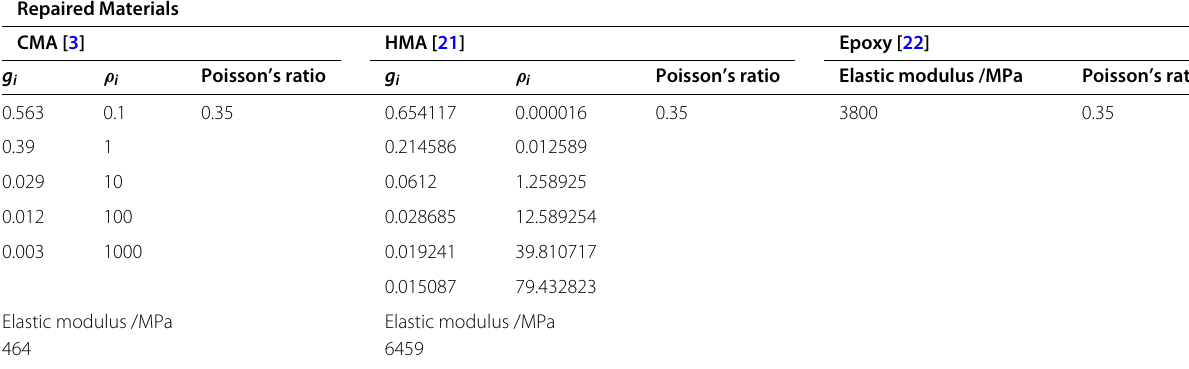
Table 2 Repaired materials Prony Series parameters Repaired